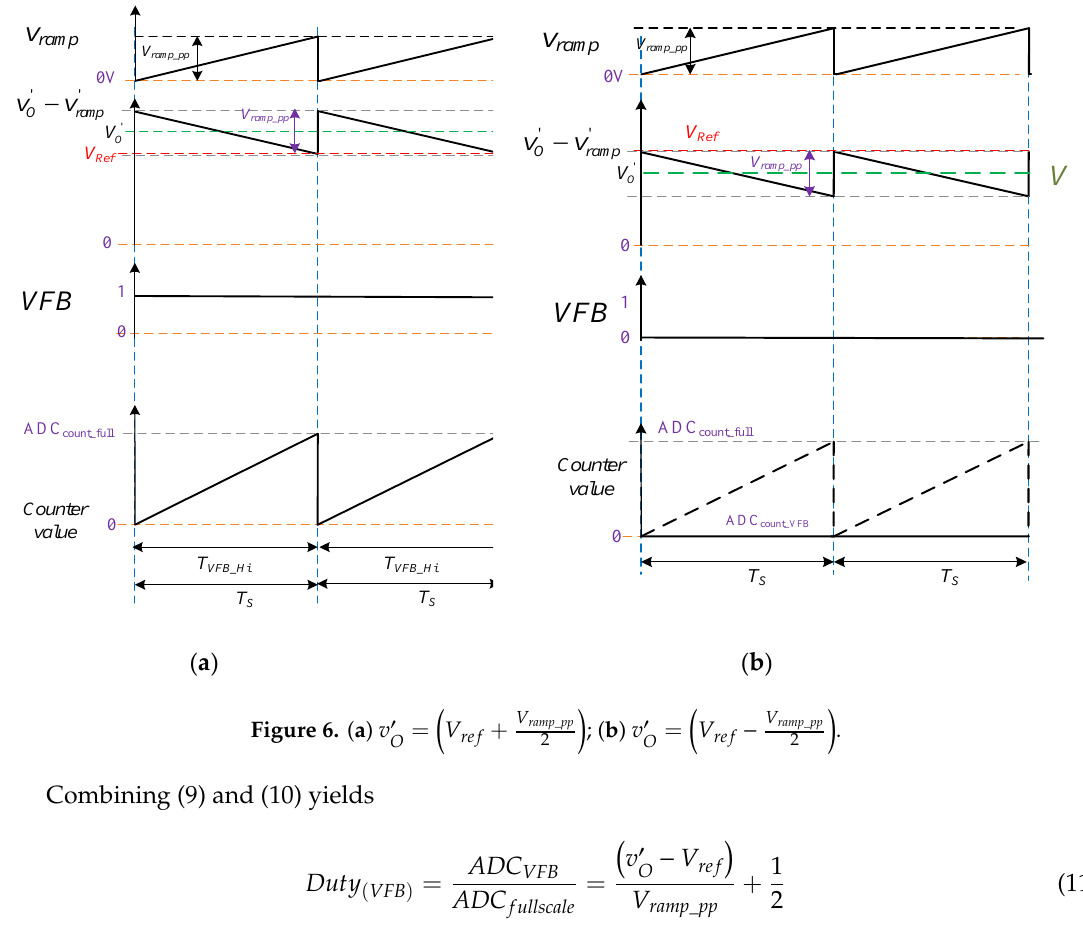
Figure 6. ( a ) Figure 6. ( a ) v (cid:48)